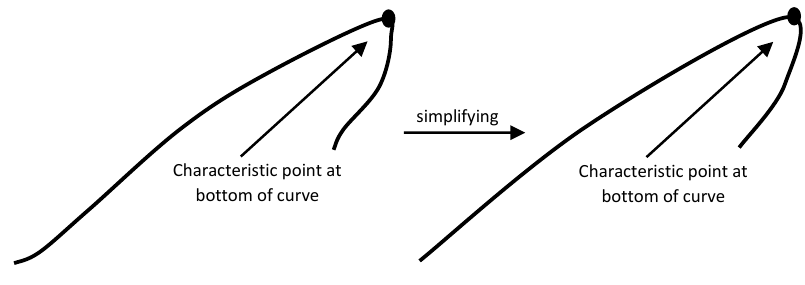
Figure 13. The method of simplifying large V-shaped curves.